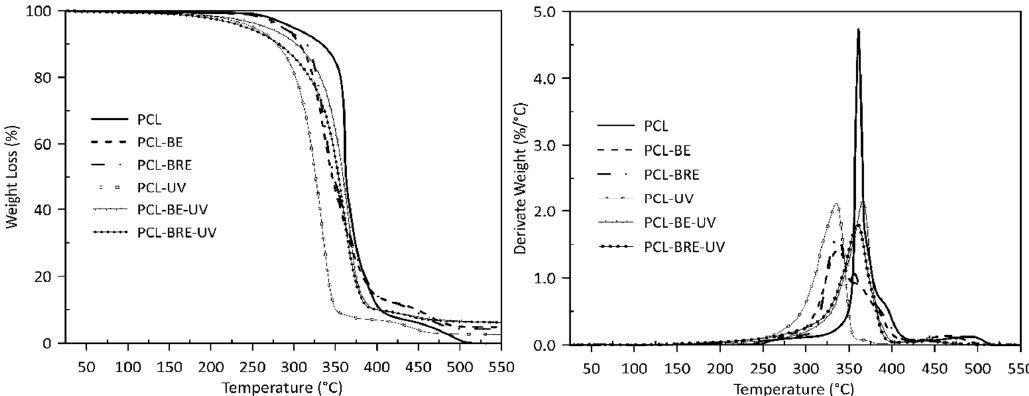
Figure 6. Thermogravimetric response of PCL bentonite with AO alongside the reference samples. Table 3. Summary of TGA curves for the PLA, PCL, and composites. Samples